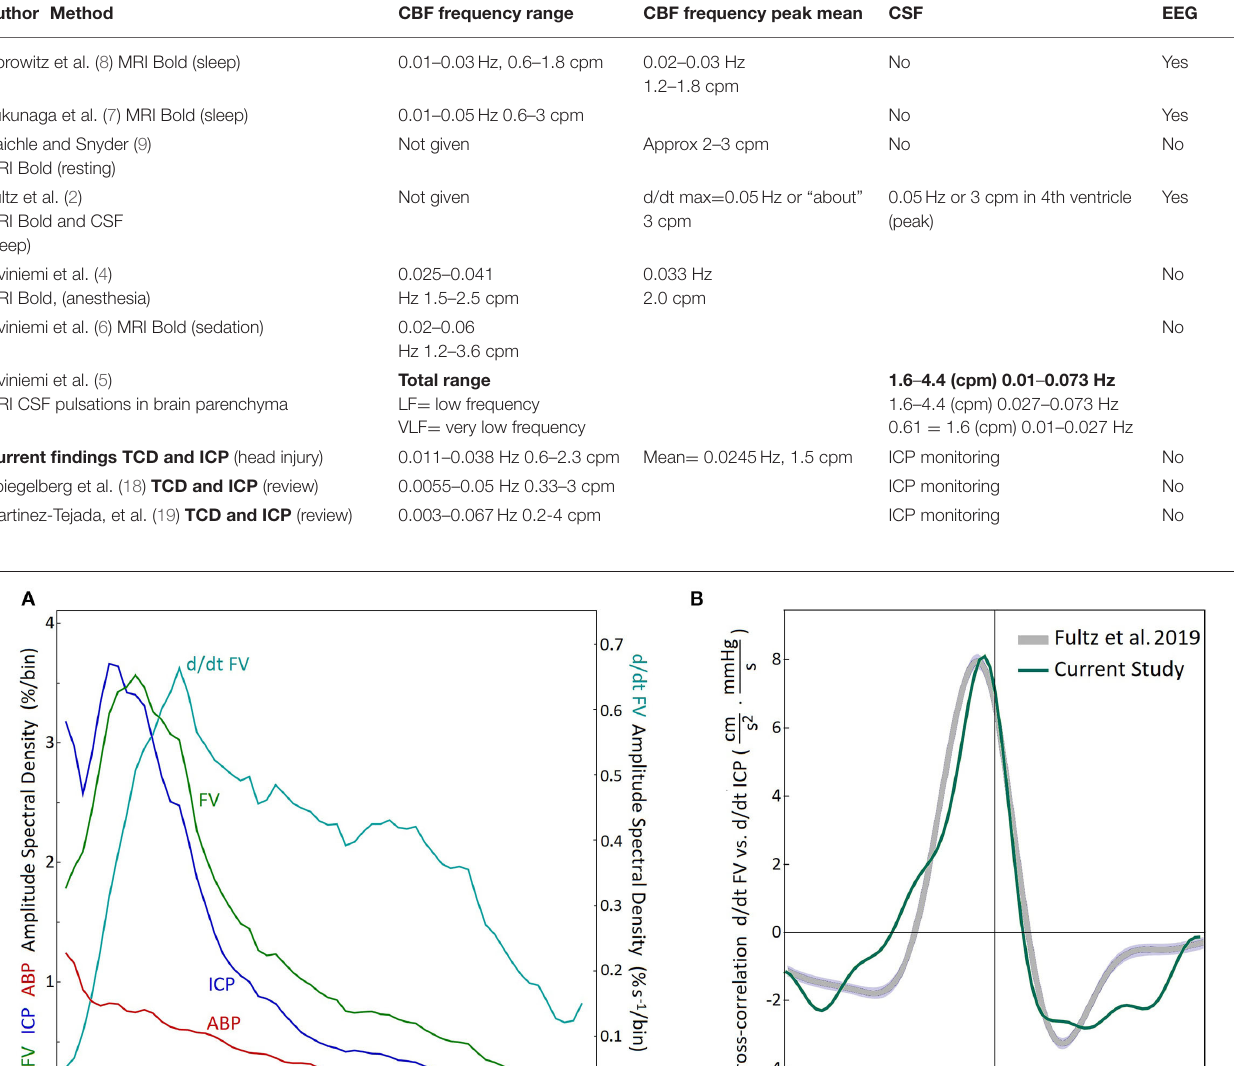
TABLE 2 | Human studies comparing frequency measurements of slow wave CBF and CSF oscillations using MRI imaging (upper) vs. analysis of TCD derived CBF, and ICP pressure measured oscillations (lower) cpm, cycles per min; Hz, cycles per sec.